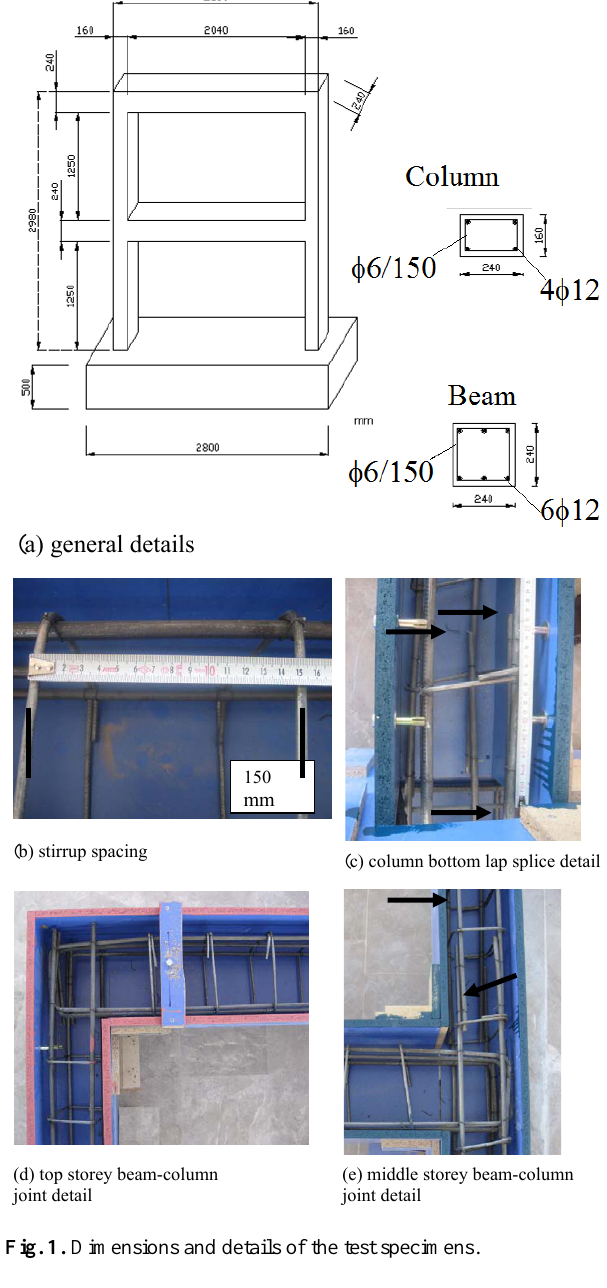
Fig. 1. Dimensions and details of the test specimens.